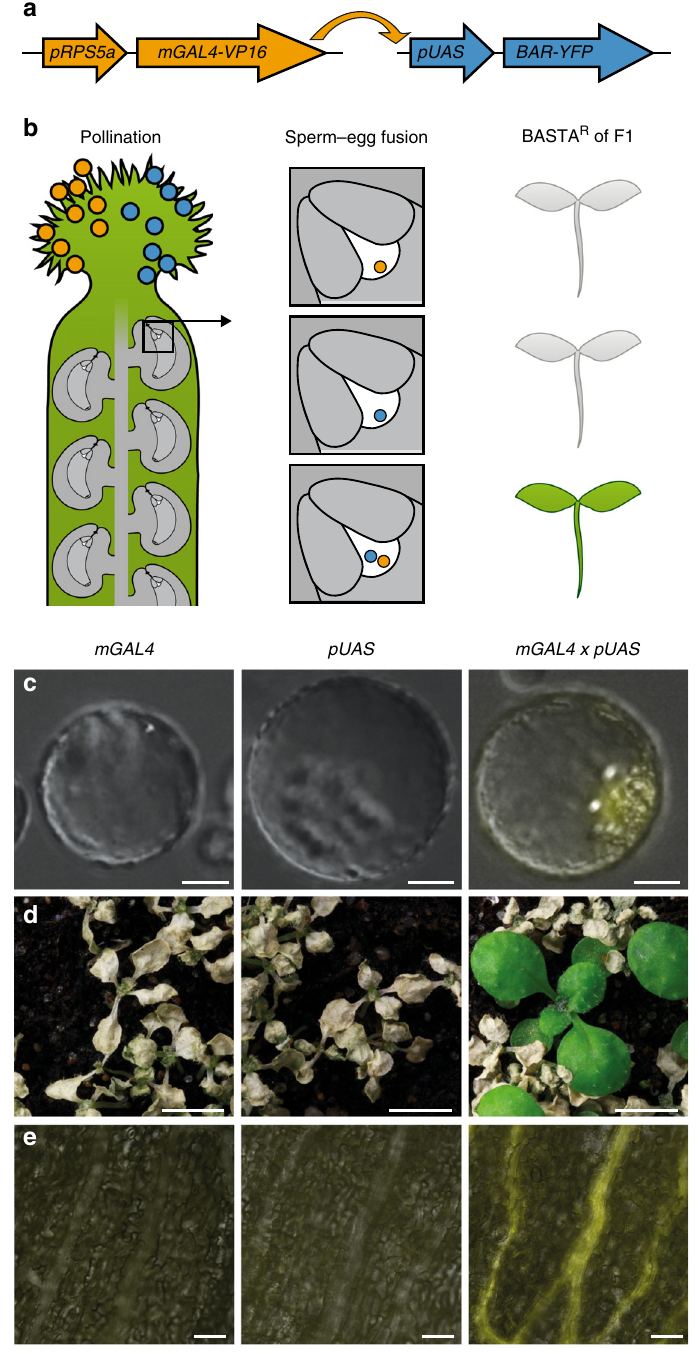
Fig. 1 Establishment of a high-throughput polyspermy detection assay. a HIPOD comprises the synthetic transcription factor mGAL4 driven by the ubiquitous RPS5a promoter, which transactivates the UAS promoter driving a herbicide resistance-conferring YFP -tagged BAR gene. b Pollen from PD1 (orange) and PD2 (blue) harboring the individual components of the two-component system are applied to the stigma of a gynoecium (green). Fusion of two sperm from two different fathers (orange, blue) to the egg cell (white) but not monospermy enables transactivation resulting in herbicide-resistant F1 plants. c Fluorescence microscopy of protoplasts transformed with pRPS5a::mGAL4-VP16 (left), pUAS::BAR-YFP (middle) or cotransfected with pRPS5a:: mGAL4-VP16 and pUAS::BAR-YFP (right). d Herbicide-treated F1 plants resulting from sel fi ng of pRPS5a::mGAL4-VP16/ + (left), sel fi ng of pUAS::BAR-YFP/ + (middle), and a cross between pRPS5a::mGAL4-VP16/- and pUAS::BAR-YFP/- (right). e YFP fl uorescence analysis in sepals of F1 plants resulting from sel fi ng of pRPS5a::mGAL4-VP16/ + (left), sel fi ng of pUAS::BAR-YFP/ + (middle), and a cross between pRPS5a::mGAL4-VP16/- and pUAS::BAR-YFP/- (right). Scale bars, 15 µ m c , 0.2 cm d , and 50 µ m